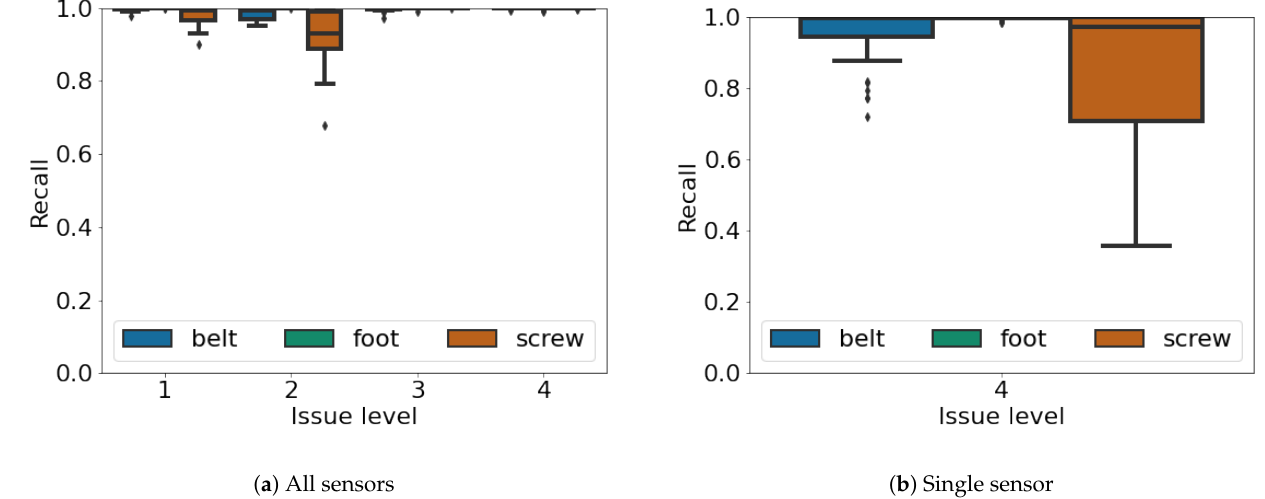
Figure 7. Recall of the classifier among different issues and different issue